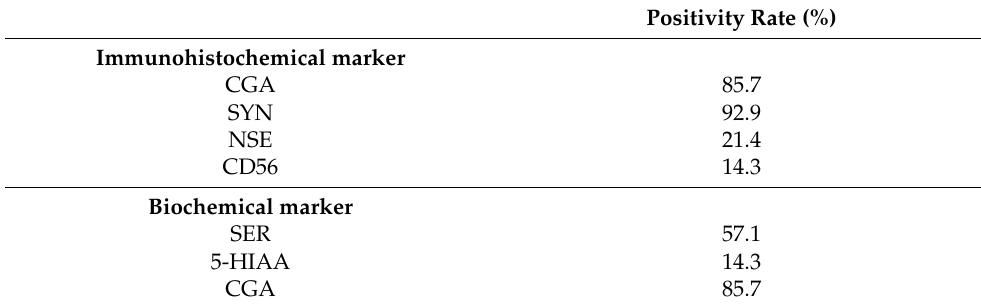
Table 2. Positivity rate for neuroendocrine markers.